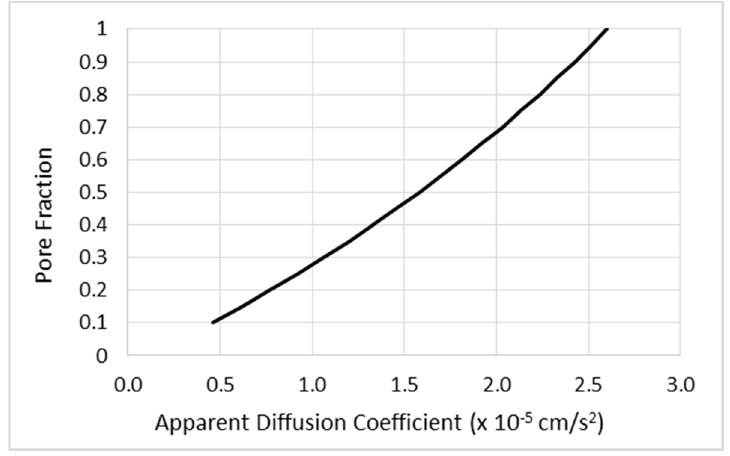
Figure 4. Estimation of pore fraction from measured apparent diffusion coefficient.